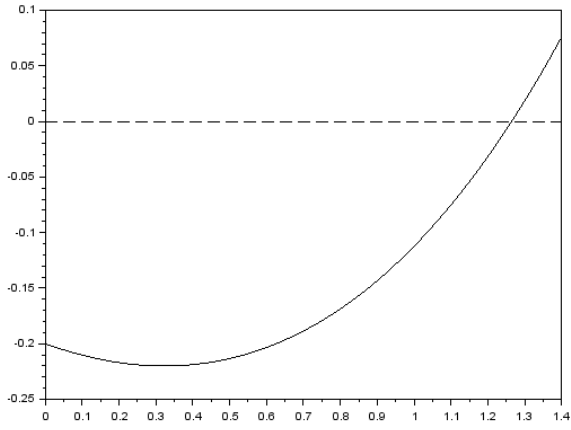
Figure 4. The shape of h(T) defined by (29), for 